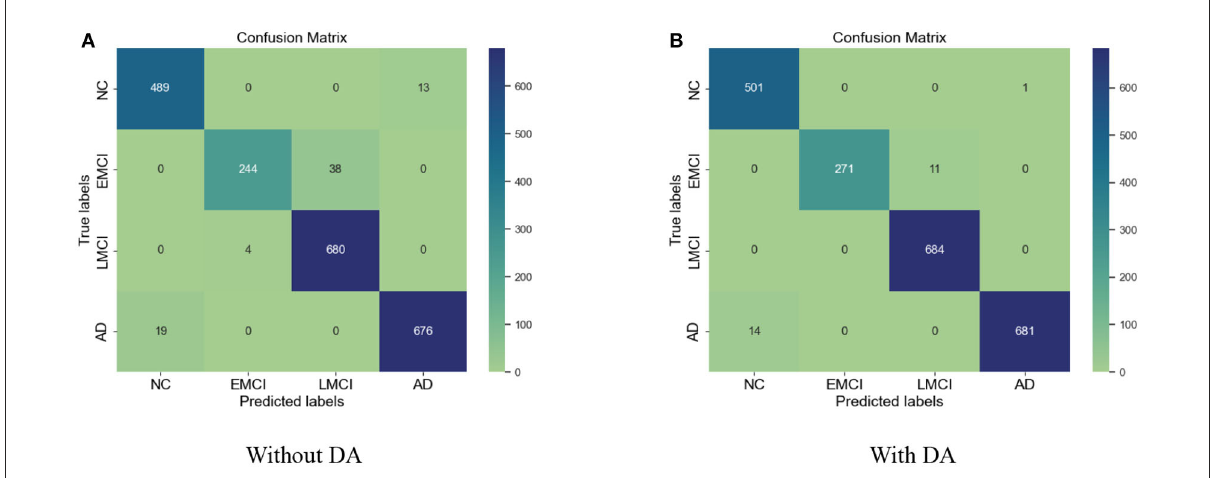
FIGURE7 (A) Confusion matrix without data augmentation (DA). (B) Confusion matrix with DA for VGG